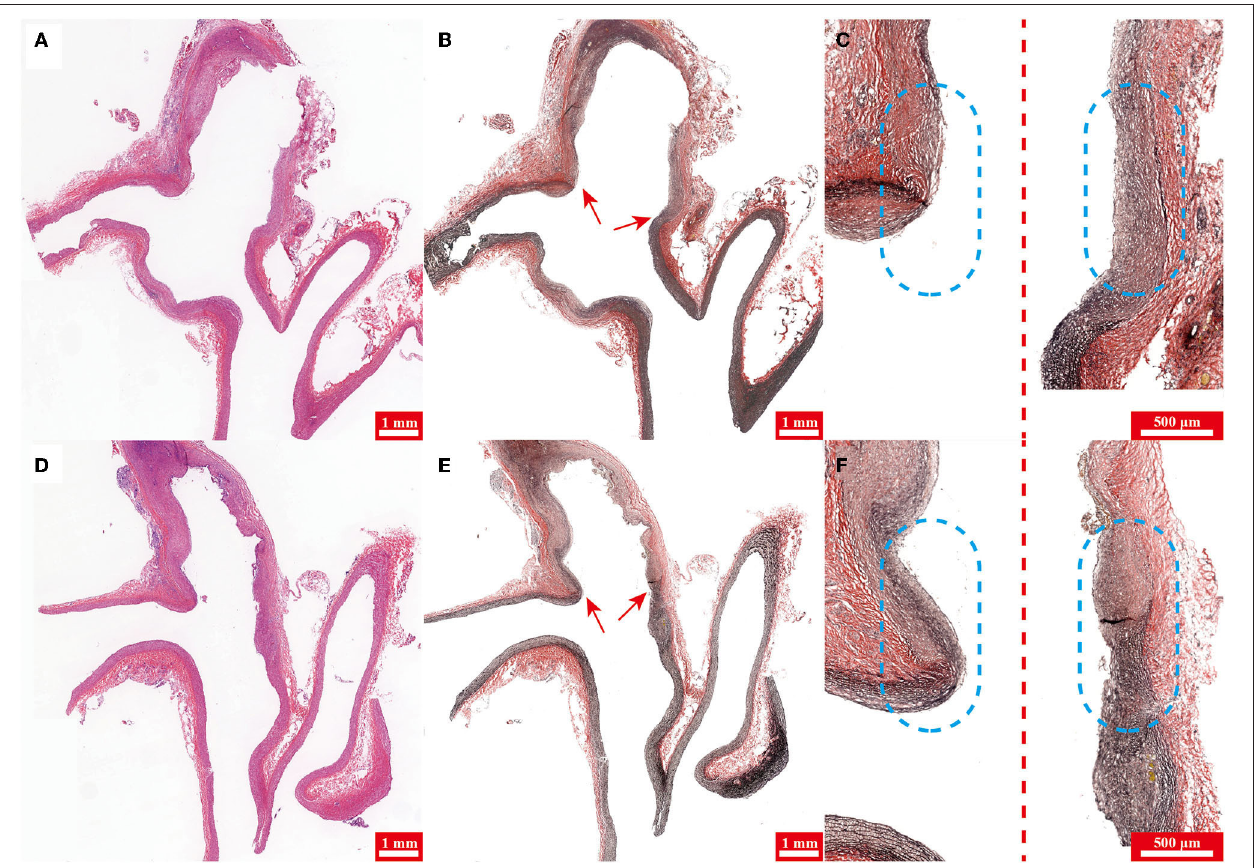
FIGURE 4 | (A,D) Hematoxylin-eosin (H&E) staining and (B,E) Verhoeff’s Van Gieson stain of specimens harvested from rabbits in groups 1 and 2, respectively. (C,F) Magnified and pieced pictures of (B,E) respectively. Note the aneurysm neck (arrow) in (B,E) . The left and right sides of the dotted line are the medial and lateral parts of specimens, respectively in (C,F) and the dashed circles highlight the aneurysm